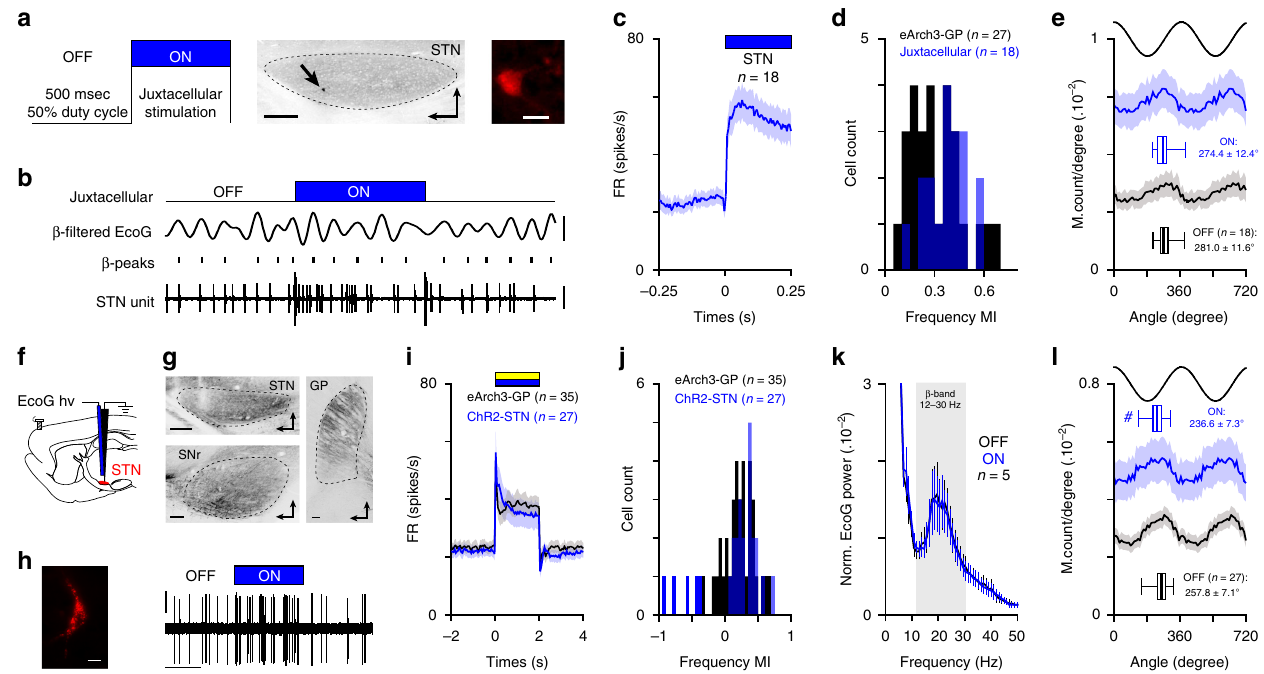
Fig. 5 Change in STN fi ring rate does not suppress abnormal β -synchronization. a Juxtacellular stimulation protocol used to increase the fi ring rate of single STN neuron as revealed by neurobiotin labeling on sagittal STN epi fl uorescence image (left image: arrow indicate cell body labeled, scale: 200 µ m; right image: neurobiotin-labeled STN neuron, scale 20 µ m). b Example of STN neuron fi ring increase during juxtacellular stimulation (scales bars are β - fi ltered ECoG: 50 µ V, spike: 2 mV, time: 750 ms). c Population PSTH of all juxtacellularly excited STN neurons recorded during β -oscillations epochs (bin: 5 ms). d Comparison of the modulatory index (MI) distribution obtained from juxtacellularly excited STN neurons as compared with disinhibited STN neurons from eArch3-GP opto-inhibition. e Mean phase histograms of the juxtacellularly excited STN neurons during β -oscillation during OFF versus ON- juxtacellular stimulation epochs. f Schematic illustration of the electrophysiological recordings in STN expressing ChR2-EYFP in 6-OHDA rats. g Sagittal epi fl uorescence images illustrating the ChR2-EYFP signal at the level of STN (top left) and axon terminals in SNr (bottom left) and GP (right). Scale bar represent 200 µ m. h Example of STN opto-excitation during laser stimulation (right, scales bars are: 0.5 mV, 1 s) and labeled with neurobiotin (left, scale bar is 20 µ m). i Comparison of population PSTH between all ChR2-excited STN neurons and all STN neurons during eArch3-GP opto-inhibition (bin: 50 ms). j Distribution of the MI obtained from ChR2-excited STN neurons and disinhibited STN neurons during eArch3-GP inhibition. k Mean normalized power spectrum of mCx ECoG during OFF and ON laser epochs (analysis on the best β epochs for each rat). l Mean phase histograms of the STN neurons during OFF and ON laser epochs. Group data represents mean ± SEM, box-and-whisker plots indicate median, fi rst and third quartile, min and max values. See also Supplementary Table 5 for statistical Table 6) with parkinsonian β (Fig. 6d and Supplementary Table 6) for prototypic, STN, and arkypallidal neurons. In con- trast to the results obtain with the STN β -patterning, we found here that the phase-locking values of prototypic and STN neurons towards synthetic cortical β -oscillations were similar to the one measured in 6-OHDA rats. Importantly, we could also reproduce the antiphase fi ring typically present between prototypic and STN neurons in PD condition, suggesting that STN β -synchronization reverse. However, unlike our previous STN opto-patterning